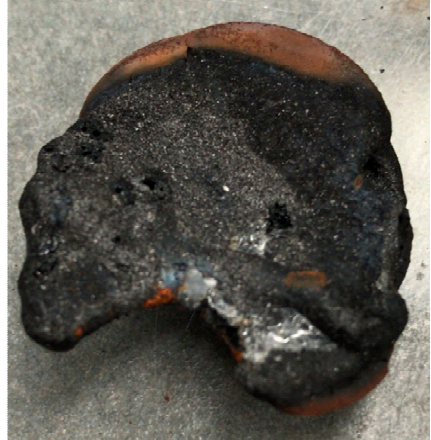
Figure 7. Tablet after 180 s irradiation time at 0.6 kW, C/BR 0.180, and 1 L/min nitrogen flow.